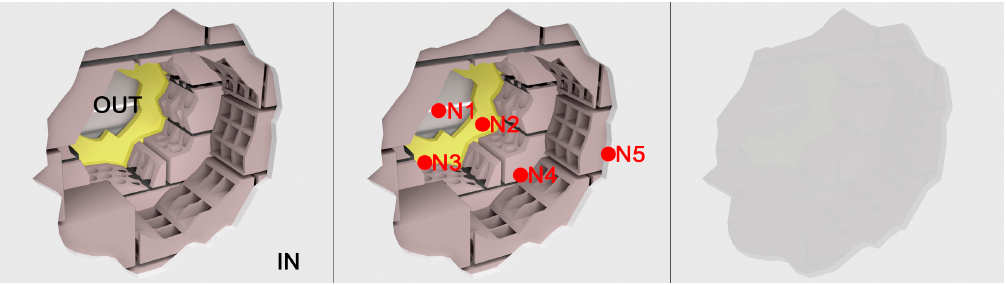
Figure 17. Picture of hole in the wall and subsequent repair using a different material.